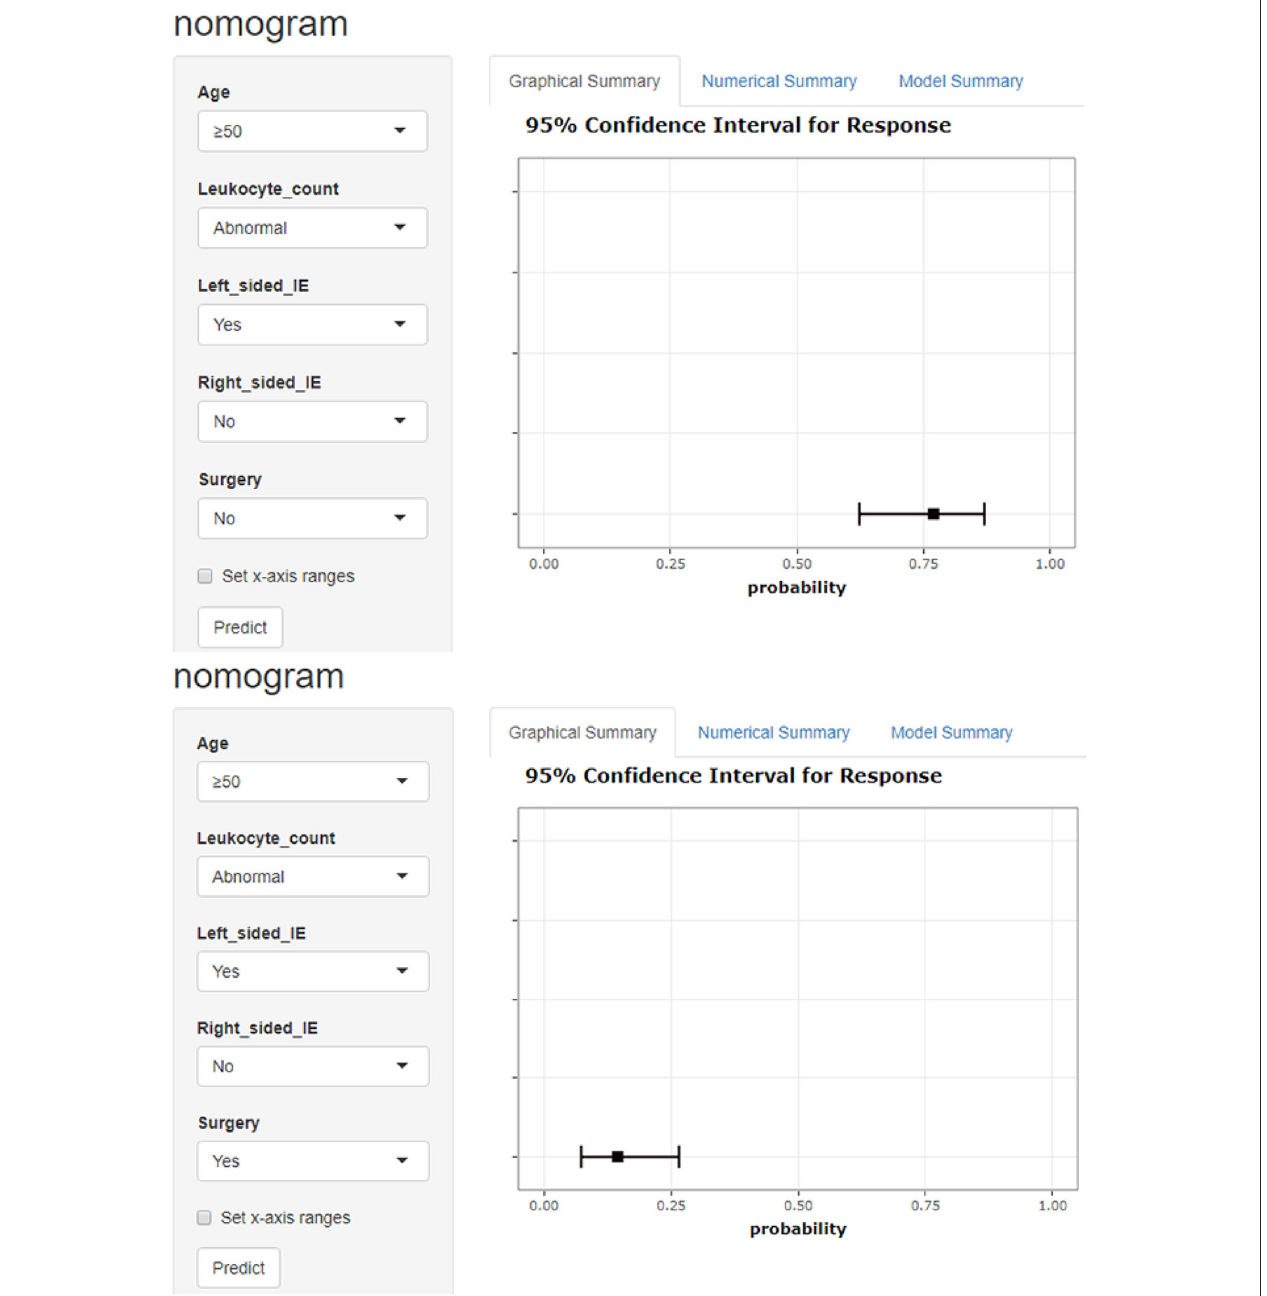
FIGURE 5 | Model-based dynamic nomogram. Entering a patient’s early clinical characteristics into a dynamic nomogram can quickly calculate the probability of in-hospital death. The picture shows a patient over 50 years old with abnormal leukocyte count and left-sided IE. The in-hospital mortality rate was 77.0% without surgery and 14.5% with